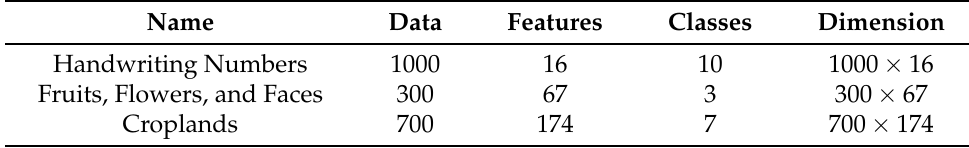
Table 4. Database